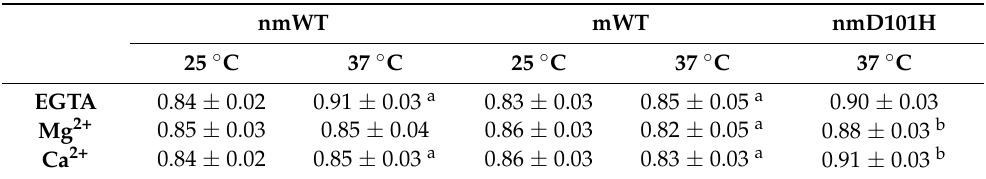
Table 2. Time evolution over 5 h of the ratio between the ellipticity at 222 nm and 208 nm of GCAP3 variants in the presence of 300 µ M EGTA; 300 µ M EGTA + 1 mM Mg 2+ ; 300 µ M Ca 2+ . Data collected at 25 ◦ C and 37 ◦ C is reported as average ± standard